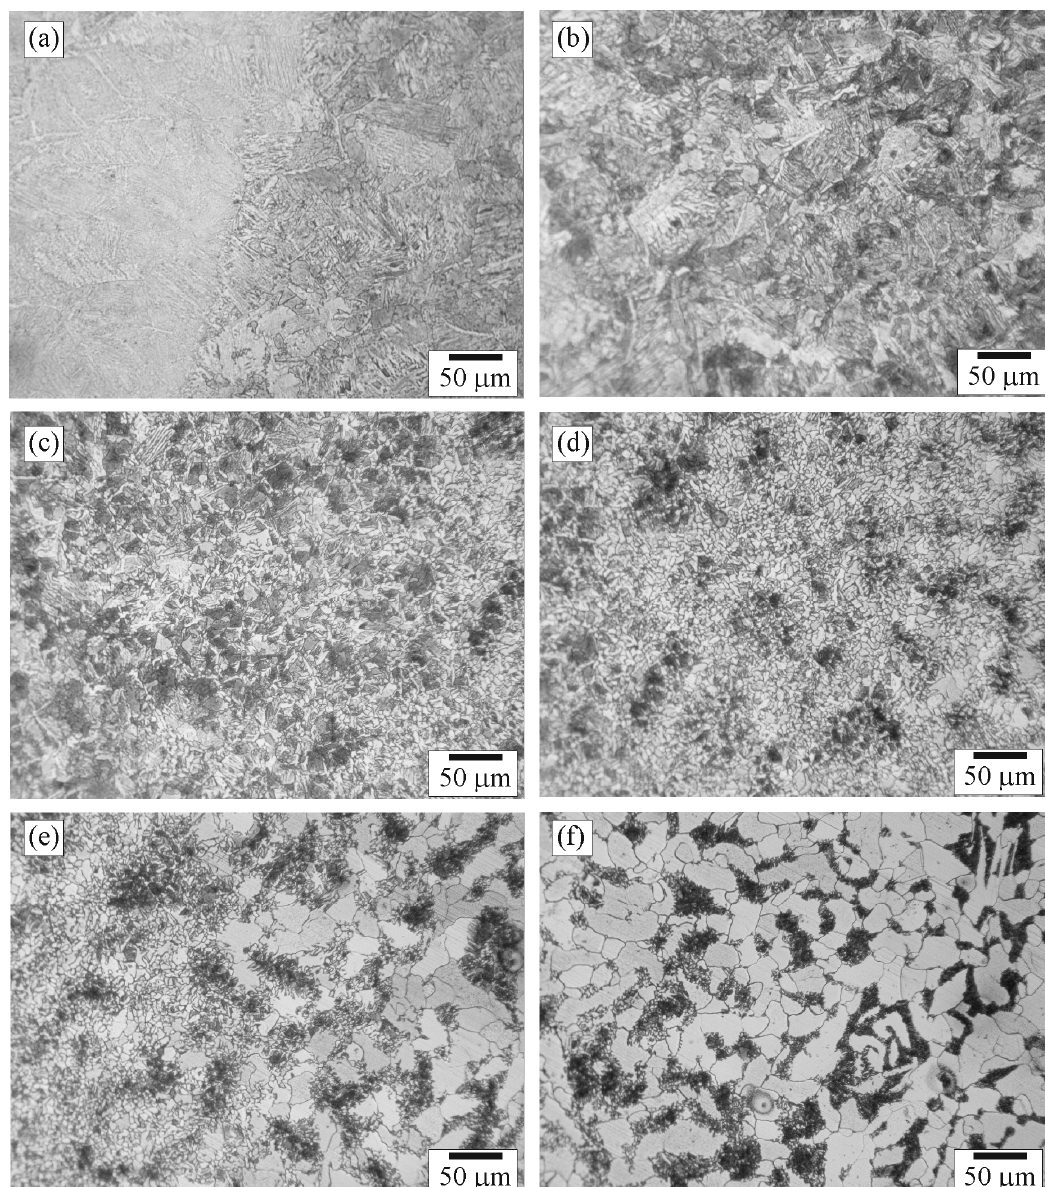
Figure 7. Optical micrographs of positions: ( a ) Da; ( b ) Db; ( c ) Dc; ( d ) Dd; ( e ) De; and ( f ) Df in Zone D.